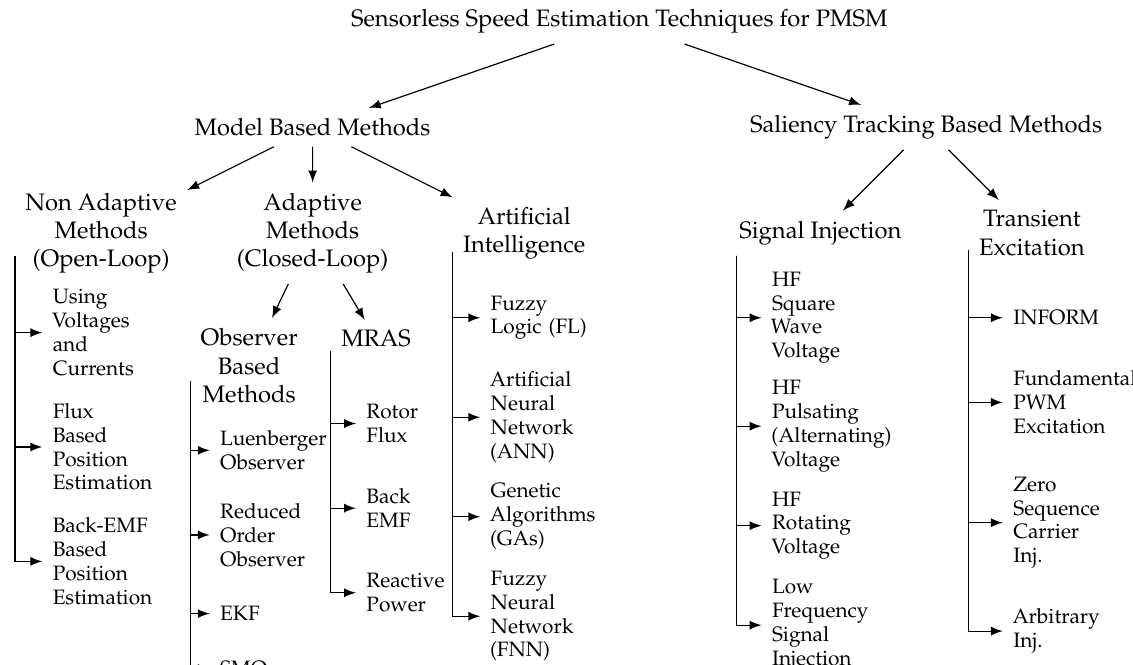
Figure 1. Classification of the sensorless control methods for a PMSM drive